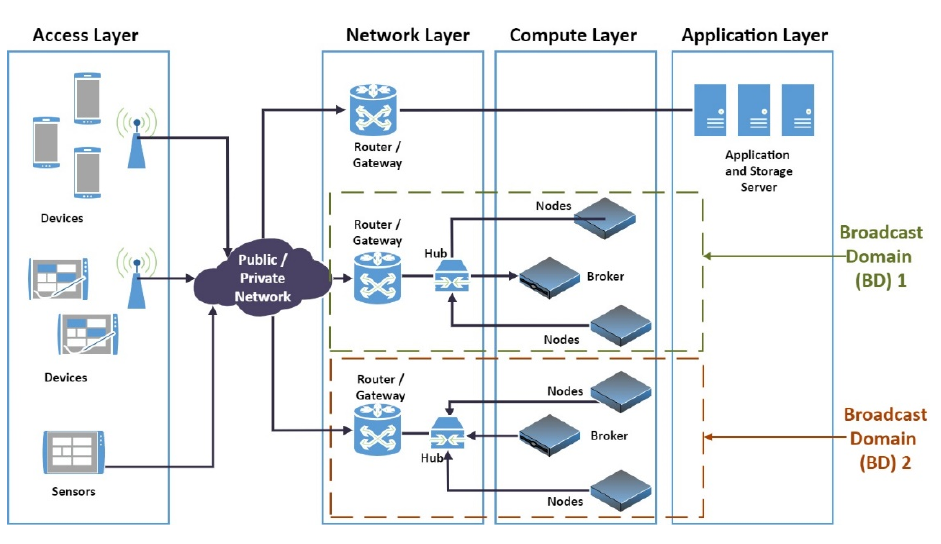
Figure 2. Lightweight Multi-Fog Topology (LMF) [13].